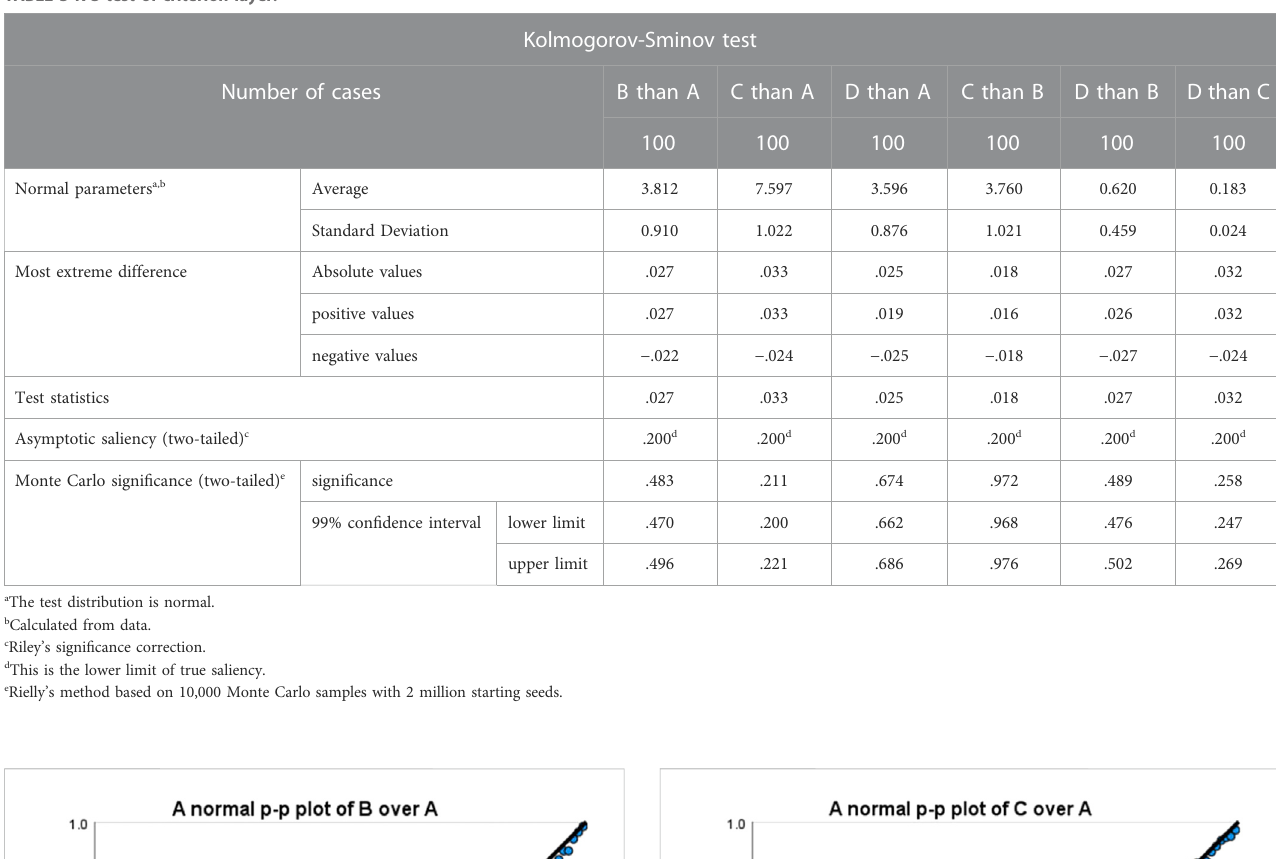
TABLE 3 K-S test of criterion layer.